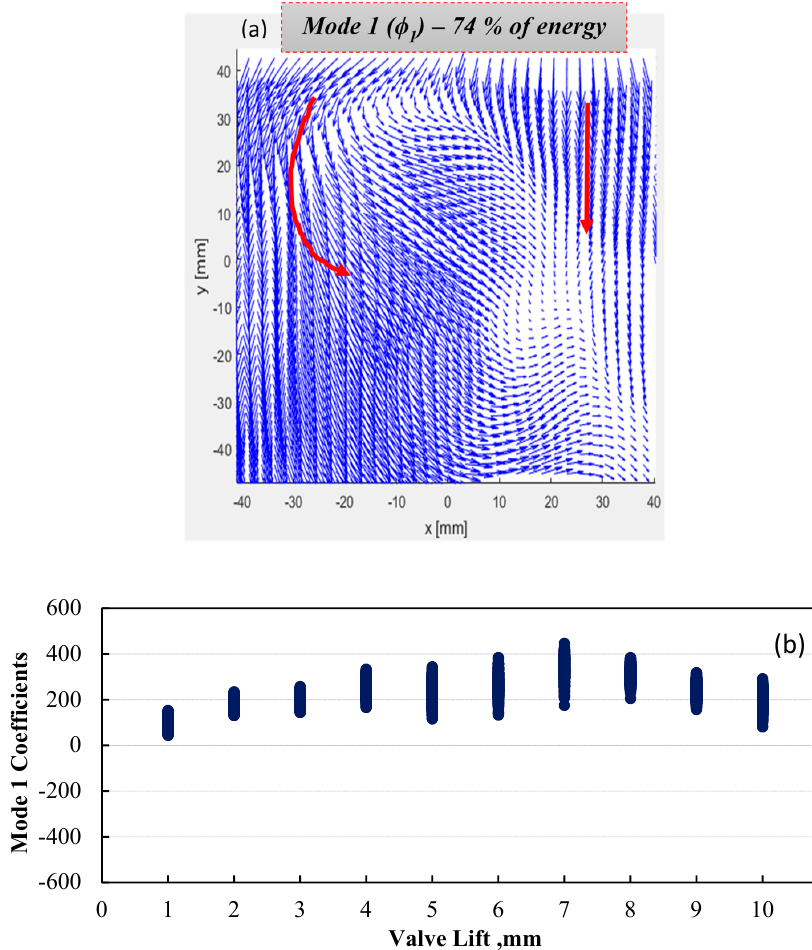
Figure 14. Flow patterns of the first POD mode ( a ) structures of modes 1; ( b ) mode 1 corresponding coefficients at different valve lifts.